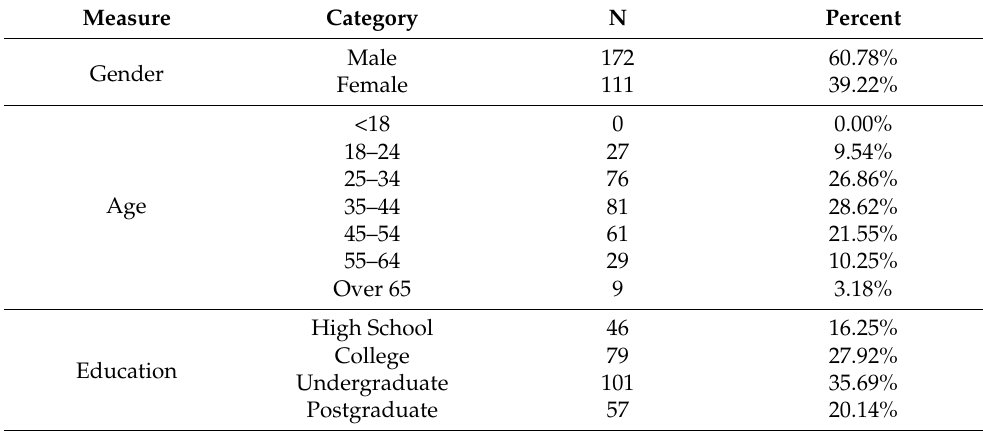
Table 1. Demographic profile of respondents (N =